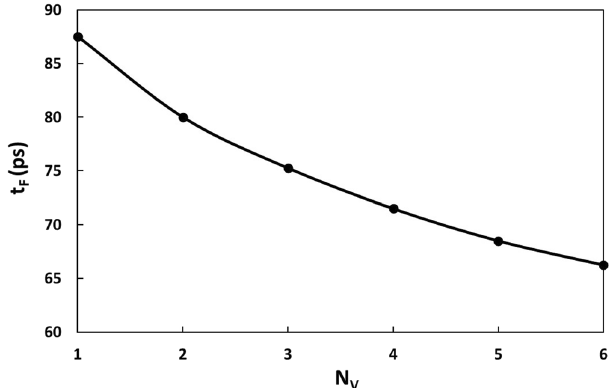
Figure 7. Variation of failure start time with the B vacancy distributions. N v is the number of layers with each containing a B vacancy. The counting of the layers starts from the top layer.